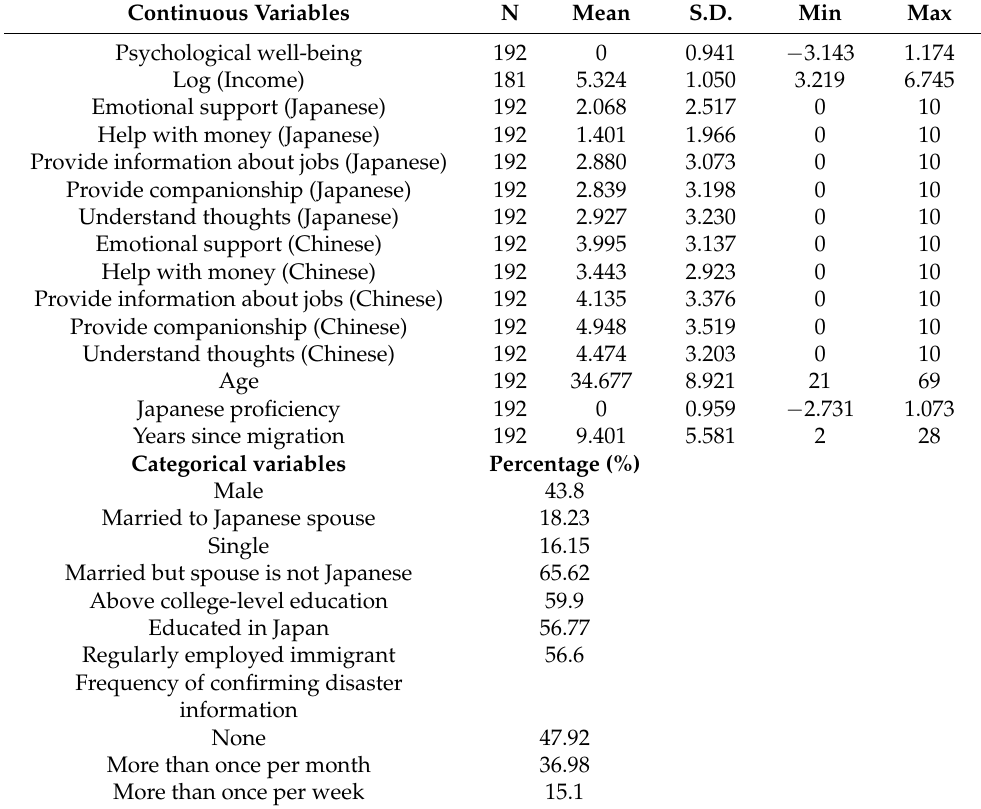
Table 1. Description of